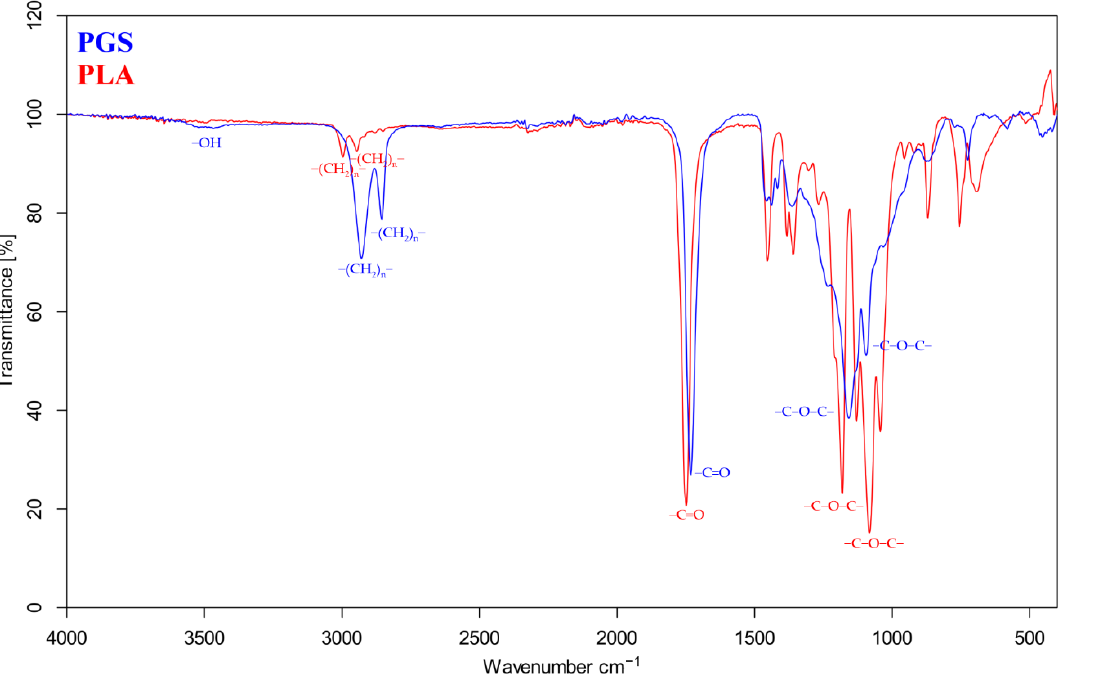
Figure 1. FT-IR spectra for studied materials: PGS — blue line, PLA — red line. The peaks corresponding to individual chemical groups are marked with the following symbols: − OH — hydroxy group, − (CH 2 ) n −— methylene groups from aliphatic chain, − C=O — carbonyl group from ester carbonyl moiety, − C − O − C − ether group from ester carbonyl moiety.